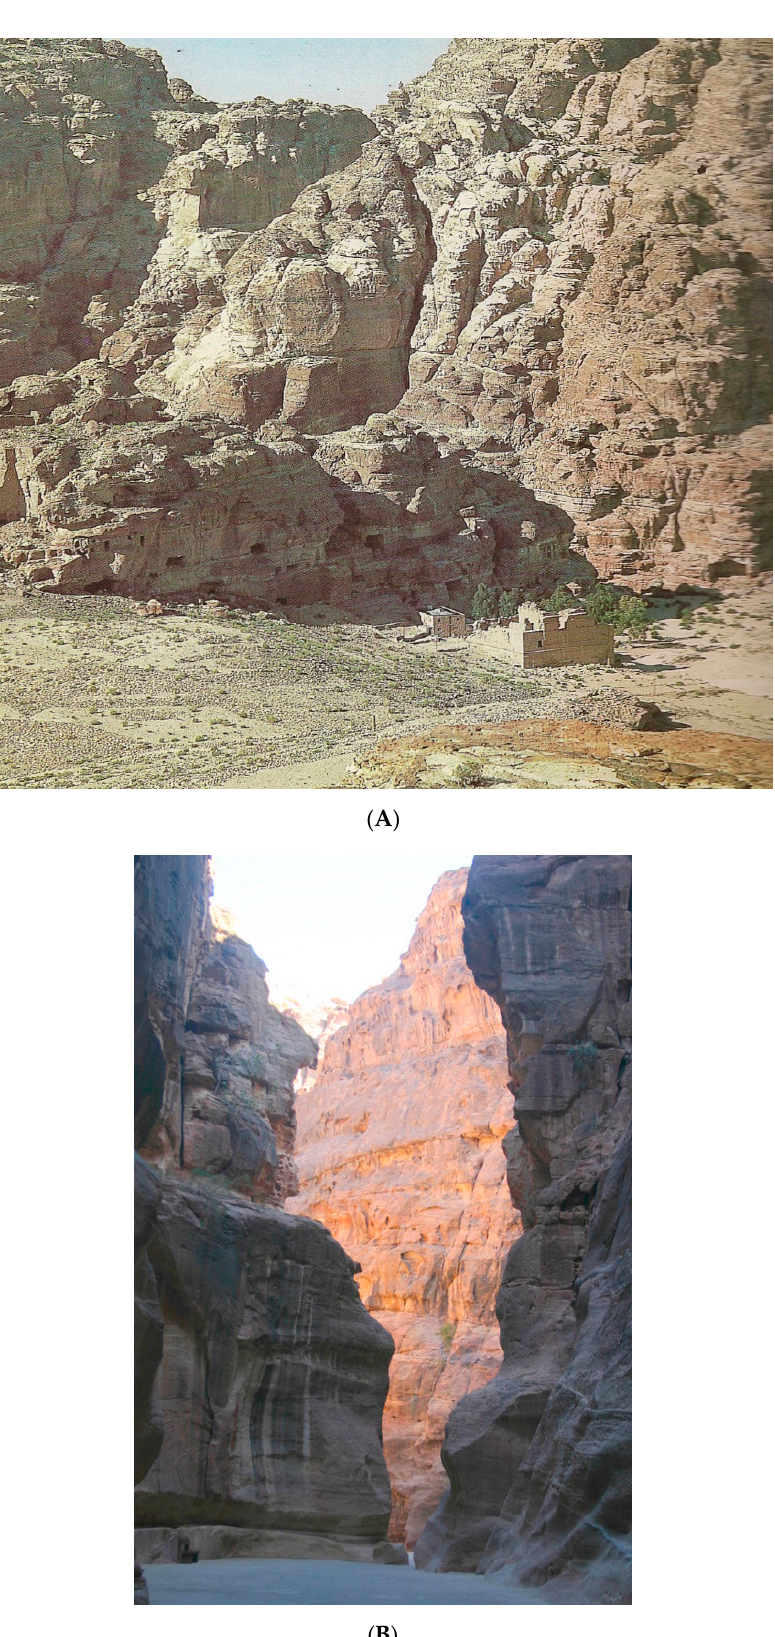
Figure 2. ( A ) The Q’asar al Bint Temple at the base of Jebel al Deir Mountain. ( B ) Narrow part of the Siq passageway; note the figure located on the passageway for scale of the height of Siq near vertical walls.